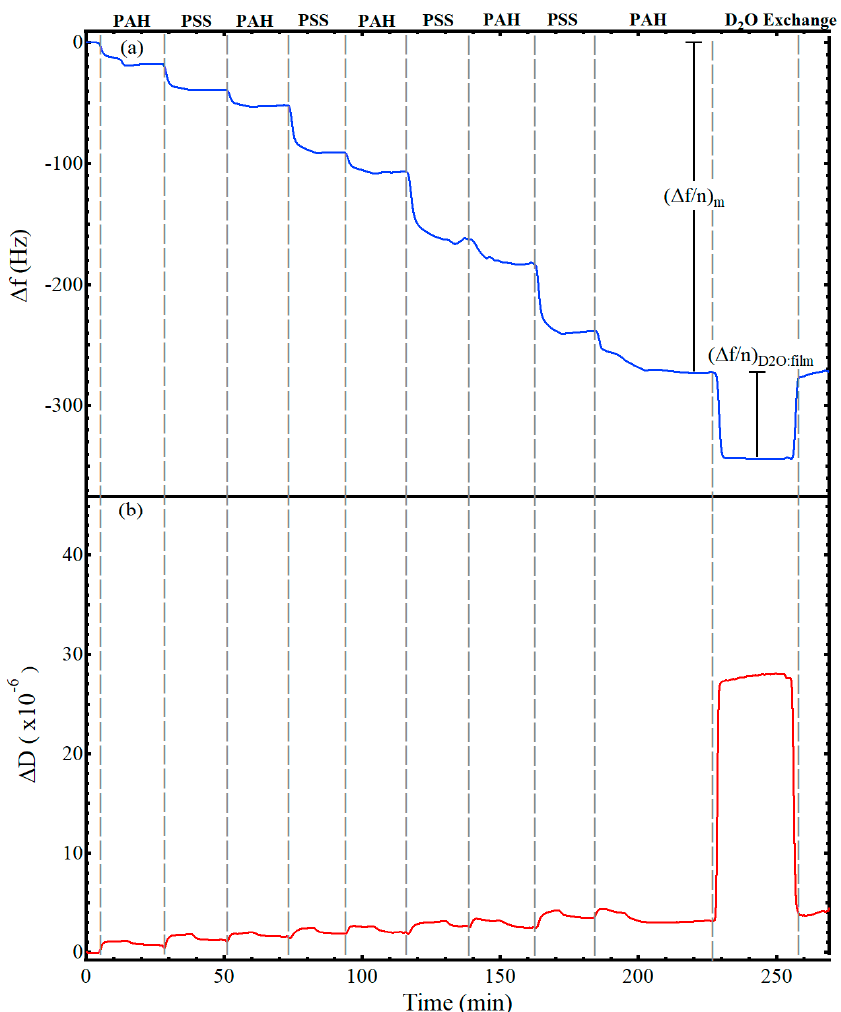
Figure 2. Frequency ( a ) and dissipation ( b ) values for the LbL adsorption of a nine-layer PAH/PSS polyelectrolyte film followed by D 2 O solvent exchange. The top of the figure annotates the poly- electrolyte layer adsorbed, while space between the vertical, dashed, gray lines include both the time for the polyelectrolyte adsorption and the associated salt rinse. The change in frequency used to calculate the hydrated surface excess ∆ m (Equation (1)) is annotated as ( ∆ f/n) m . The change in frequency for the deuterated solvent exchange of the adsorbed film used to determine the film water content Equation (3) is annotated as ( ∆ f/n) D2O:film .